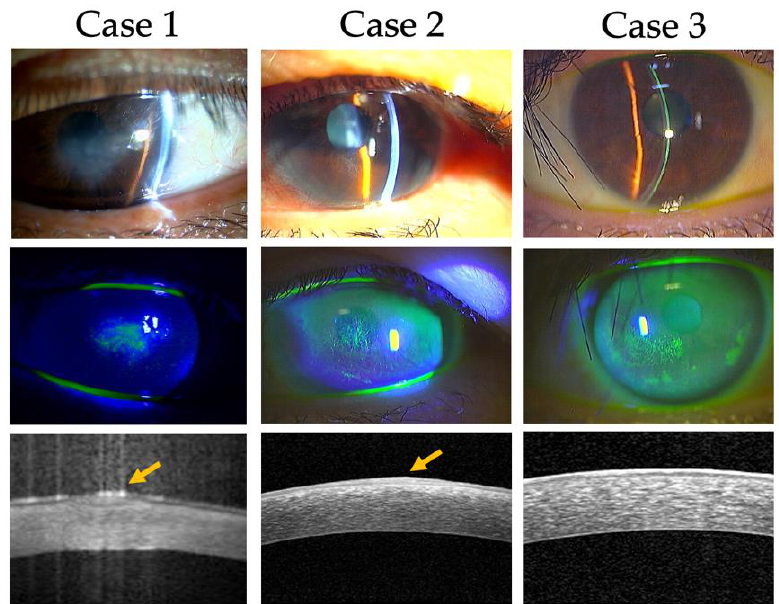
Figure 1. Characteristics of a neurotrophic keratopathy evaluated by slit-lamp examination. Neurotrophic keratopathy is present in the paracentral region with superficial stromal opacity. The vortex pattern, known as the normal healing pattern, was not observed with fluorescein staining. Focal thickening of the epithelium was sustained after erosion, which indicates disturbances in the healing process. Anterior segment optical coherence tomography also showed focal thickening of the epithelium with high density.